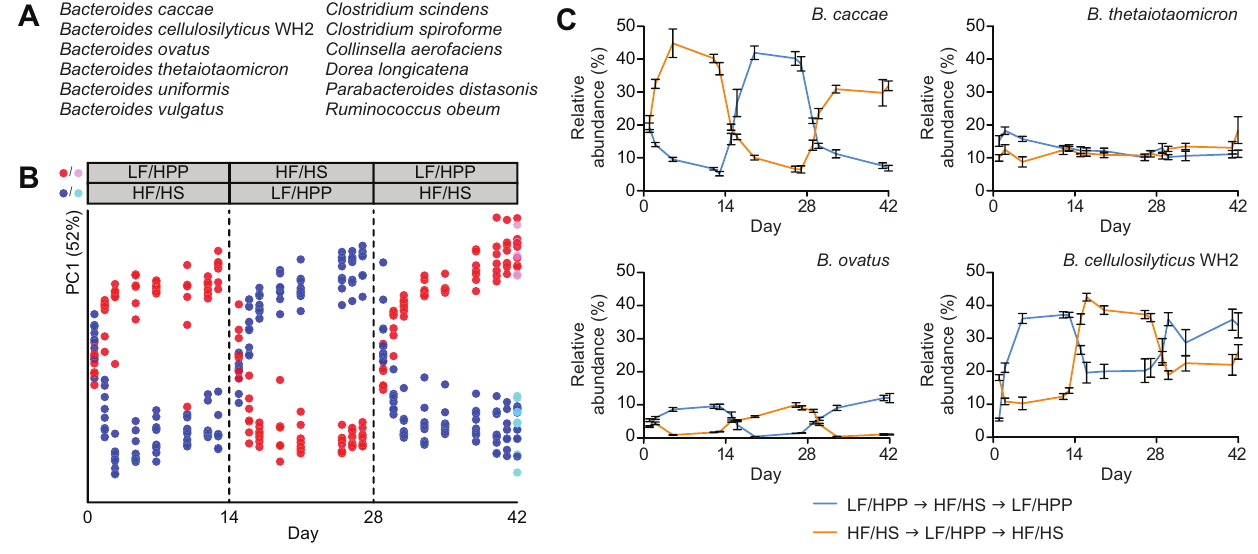
Figure 1. COPRO-Seq analysis of the structure of a 12-member artificial human gut microbial community as a function of diet and time. (A) The 12 bacterial species comprising the artificial community. (B) Principal coordinates analysis (PCoA) was applied to relative abundance data generated by COPRO-Seq from two experiments (E 1 , E 2 ), each spanning 6 wk. Following colonization (day 0), mice were switched between two different diets at 2-wk intervals as described in Figure S3. COPRO-Seq data from E 1 and E 2 were ordinated in the same multidimensional space. For clarity, only data from E 2 are shown here (for the E 1 PCoA plot, see Figure S5A). Red/blue, feces; pink/cyan, cecal contents. (C) Proportional abundance data from E 1 illustrating the impact of diet on fecal levels of a diet-sensitive strain with higher representation on HF/HS chow ( B. caccae ), a diet- sensitive strain with higher representation on LF/HPP chow ( B. ovatus ), a diet-insensitive strain with no obvious diet preference ( B. thetaiotaomicron ), and a diet-sensitive strain with a preference for the LF/HPP diet that also achieves a high level of representation on the HF/HS diet ( B. cellulosilyticus WH2). Mean values 6 SEM are shown. Plots illustrating changes in abundance over time for all species in both experiments are provided in Figure S4C.